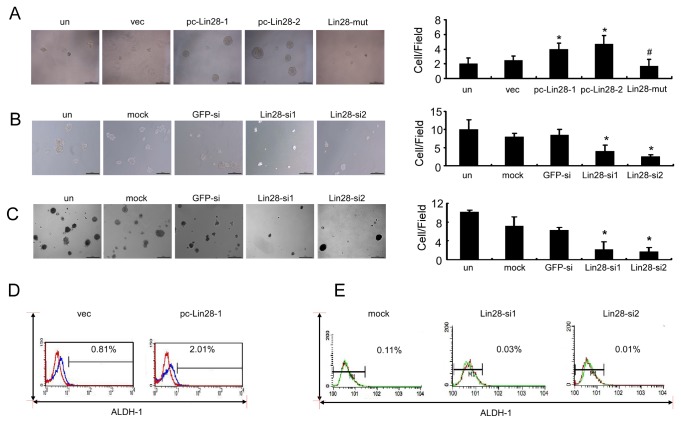
Lin28 increased the mammosphere formation rate and ALDH1 activity in breast cancer cells.A and B. Sphere-forming assay revealed that the Lin28 stably expressed MCF-7 clones pc-Lin28-1 and pc-Lin28-2 displayed an increased mammosphere formation rate when compared with empty vector and Lin28-mut transfectants (A). Meanwhile, the mammashpere formation rate was remarkably decreased in MDA-MB-231 cells that had been transfected with Lin28-siRNA (B). C. A soft-agar assay revealed that colony formation decreased in MDA-MB-231 cells after transfection with Lin28-siRNAs. D and E. By FCM, pc-Lin28-1 cells showed a 3-fold increase of ALDH1 activity as compared with empty vector cells (D). The proportion of ALDH1-positive cells was remarkably decreased in MDA-MB-231 cells that had been transfected with Lin28-siRNA (E). Error bars correspond to the mean ± SD. *P < 0.01 as compared to the vec or GFPsi treatment cells. Bars, 500 μm.